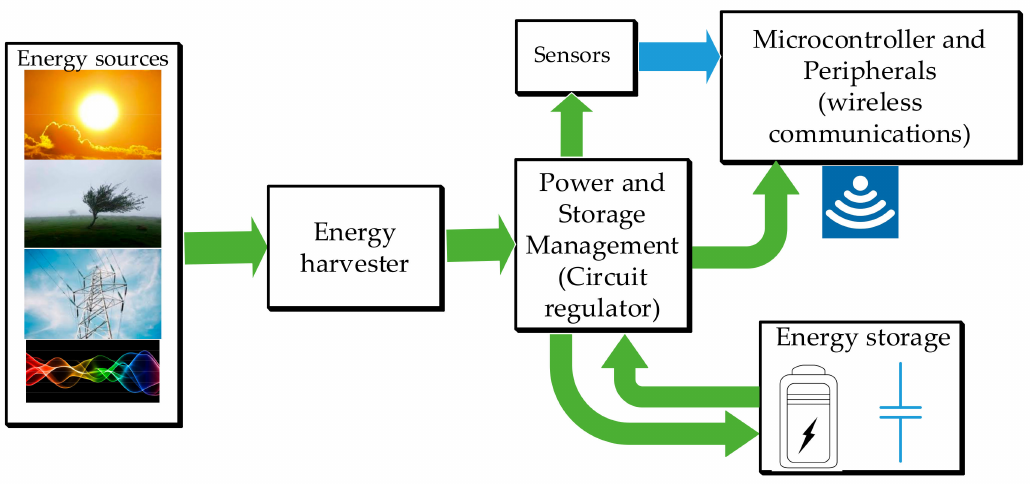
Figure 1. Block diagram of an energy harvesting